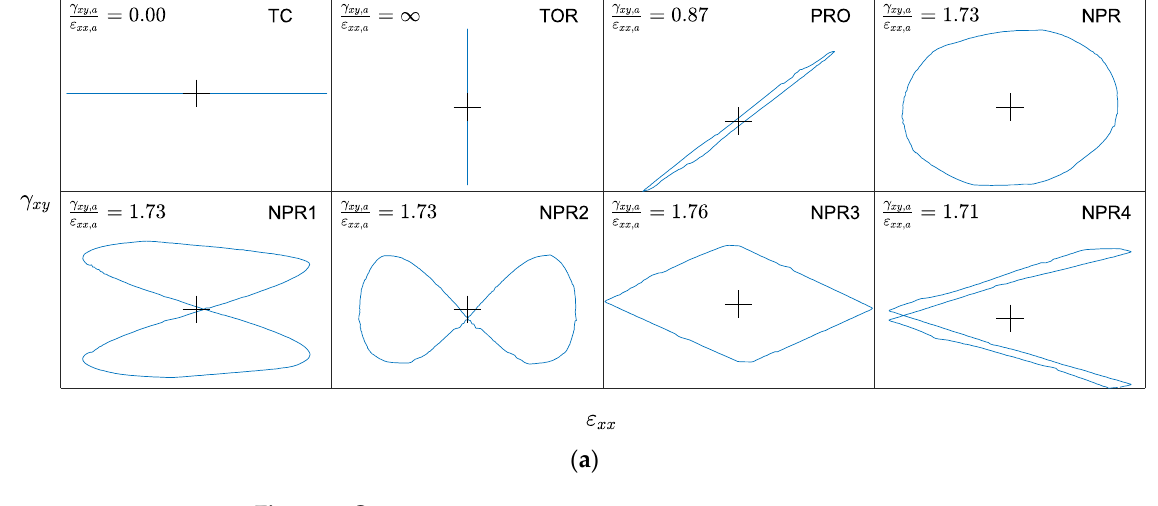
( b ) Figure 2. Registered experimental strain paths in ( a ) axial-shear strain space, 𝜀 (cid:3051)(cid:3051) − 𝛾 (cid:3051)(cid:3052) and ( b ) axial-shear stress space, 𝜎 (cid:3051)(cid:3051) − 𝜏 (cid:3051)(cid:3052) . 4. Results and Discussion The normal and shear stress/strain components on the critical plane implemented in the parametric (Section 2) and GP-based fatigue life prediction (Appendix A) models were calculated based on the registered strain and stress tensor components. Searching for the plane orientation with the maximum shear strain (the critical one), numerical simulations were conducted with the application of Euler angles, 𝜑, 𝜃 —describing the plane orientation [66]. In the simulation, the step between subsequent values of the Euler angles was equal to 1°. For the non-proportional loading paths, instability in the calculated fatigue lives was detected as a result of the existence of different planes with the same maximum value of shear strain but with different normal stress and strain components. To overcome this problem, the critical plane was searched within the boundary 〈 1 − 𝛿, 1 〉 max 𝜑,𝜃 𝛾 𝑛𝑠 , where 𝛿 = 0.0001 was applied. Within this boundary, the maximum values of normal stress, normal strain, and shear stress were determined and applied to the fatigue life calculations (the values could be found in the file uploaded to https://data.mendeley.com/datasets/7fbkf6y7gv/1, accessed on 25 October 2021). 4.1. Error Indexes The calculated fatigue lives were compared with the experimental fatigue lives to estimate the performance of each applied fatigue model. A few error indexes were